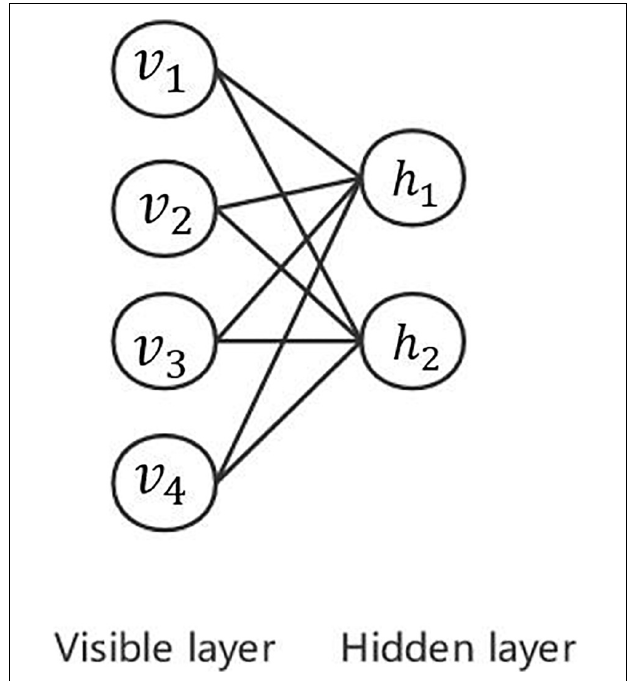
FIGURE 8 | Illustration of restricted Boltzmann machine.